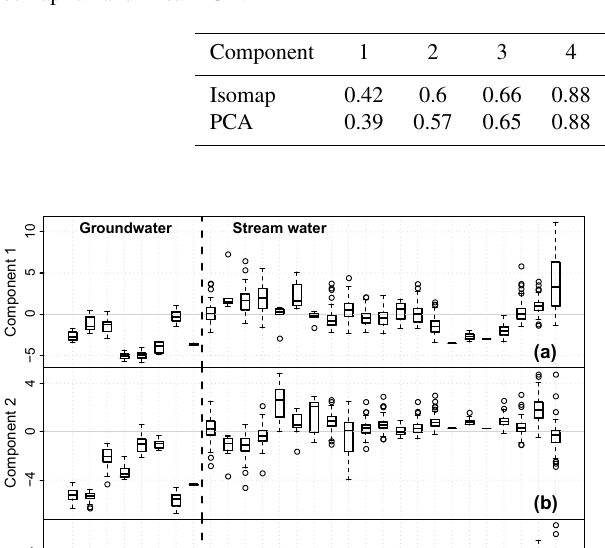
Table 2. Cumulated R 2 of the reproduction of the inter-point distances of the data in the projection by the first ten components of the best Isomap run and linear PCA.